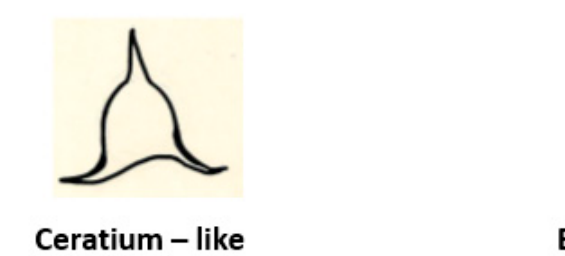
Figure 2. Examples of dinoflagellate motile body-shapes reflected be cysts.